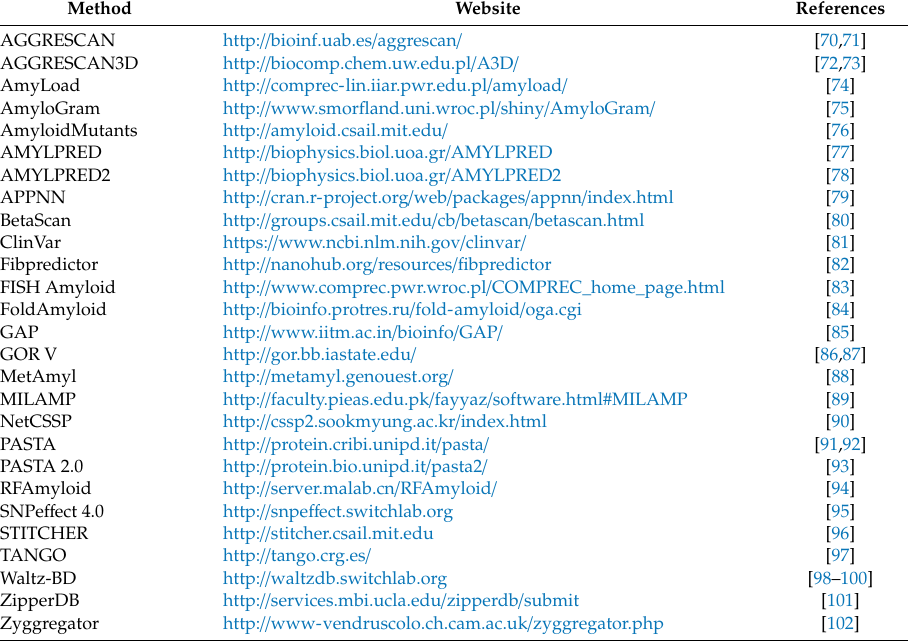
Table 2. Available online methods to predict amyloidogenic regions in amino acid